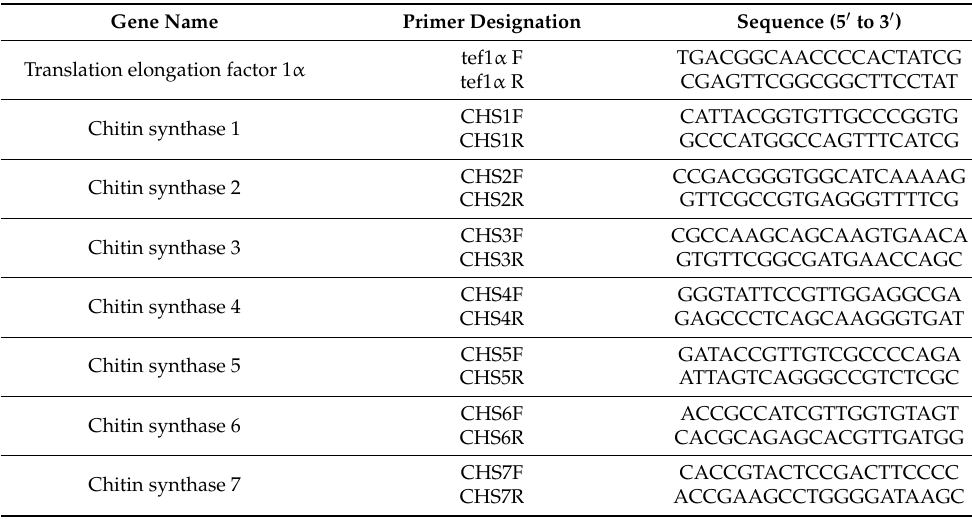
Table 1. Primers used in this